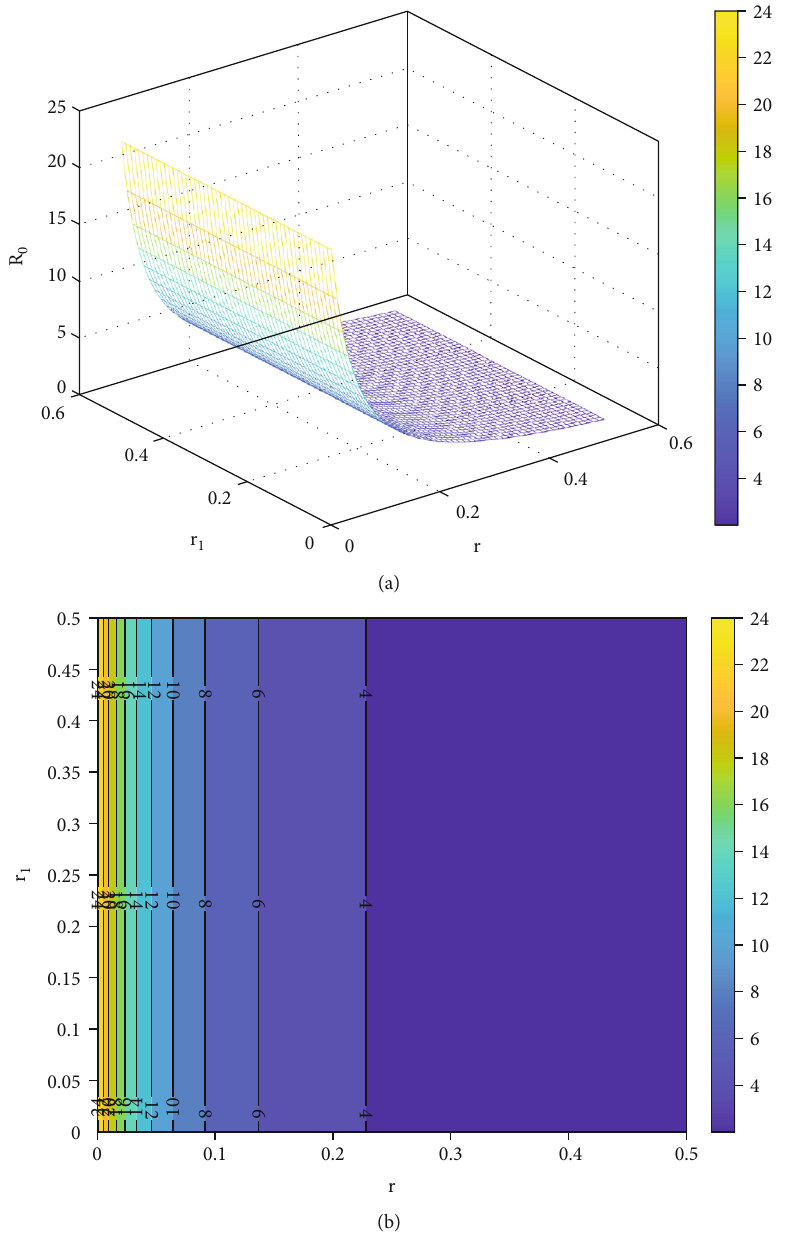
R r and r 0 vs. 1 ,